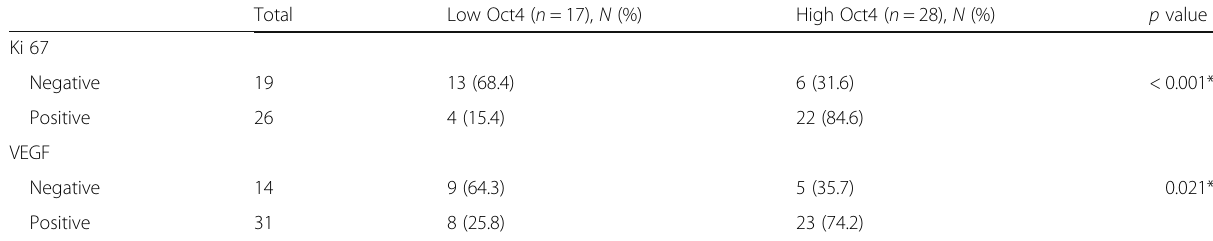
Table 3 Relation between Oct4 expression with Ki-67 and